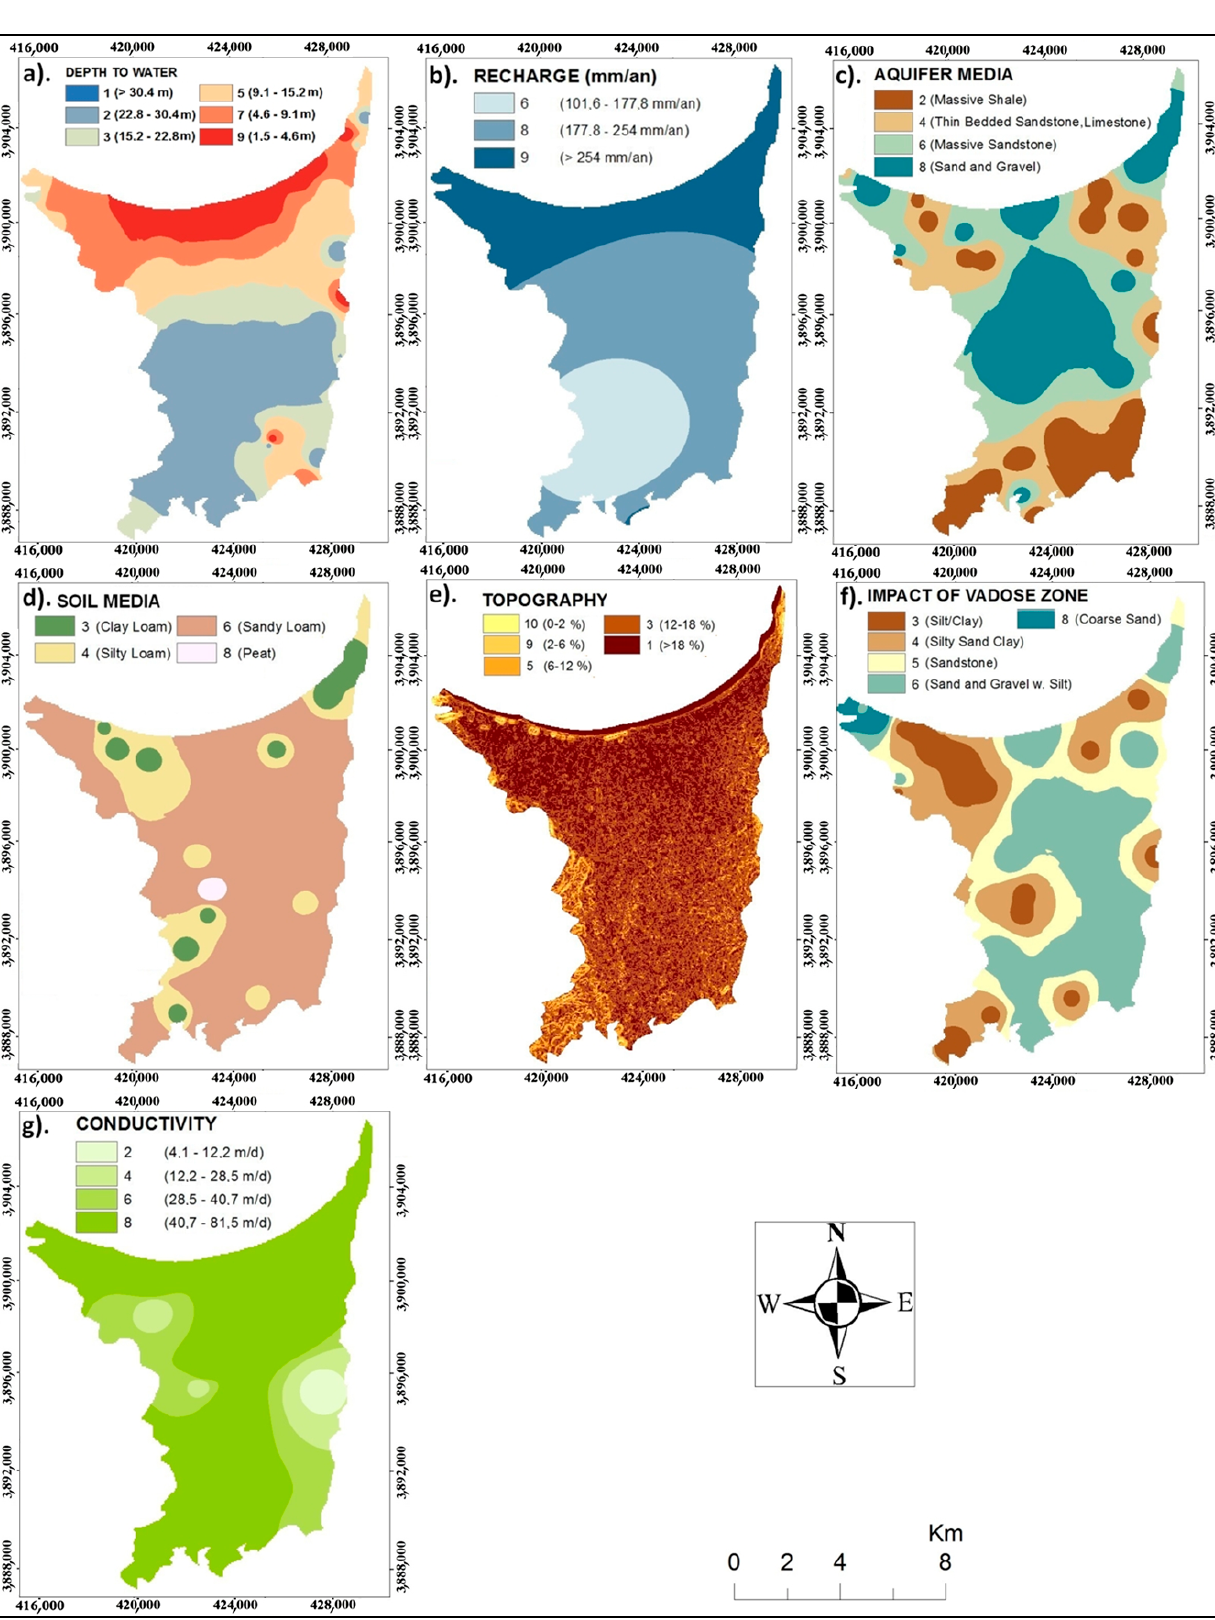
Figure 4. Maps showing the integration of ( a ) depth to water, ( b ) recharge, ( c ) aquifer media, ( d ) soil media, ( e ) topography (slope), ( f ) impact of vadose zone, and ( g ) conductivity.